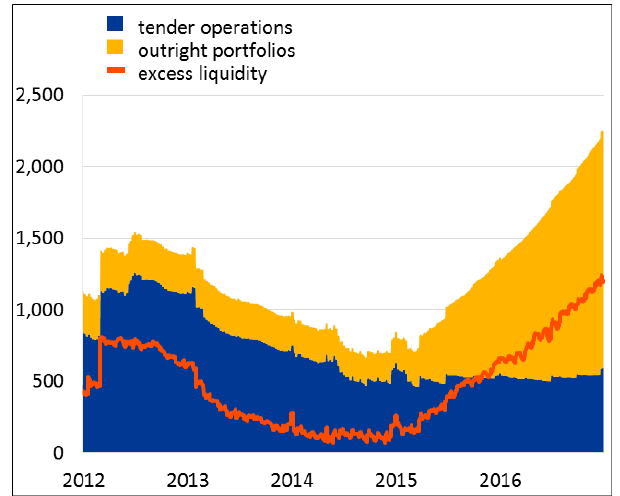
Figure 3. ECB monetary policy operations and excess liquidity (billions of euro). Source: ECB. Latest observation: 31 December 2016. Note: Tender operations include main, longer term and targeted longer term refinancing operations against eligible collateral; outright portfolios include public and private sector asset purchases in the